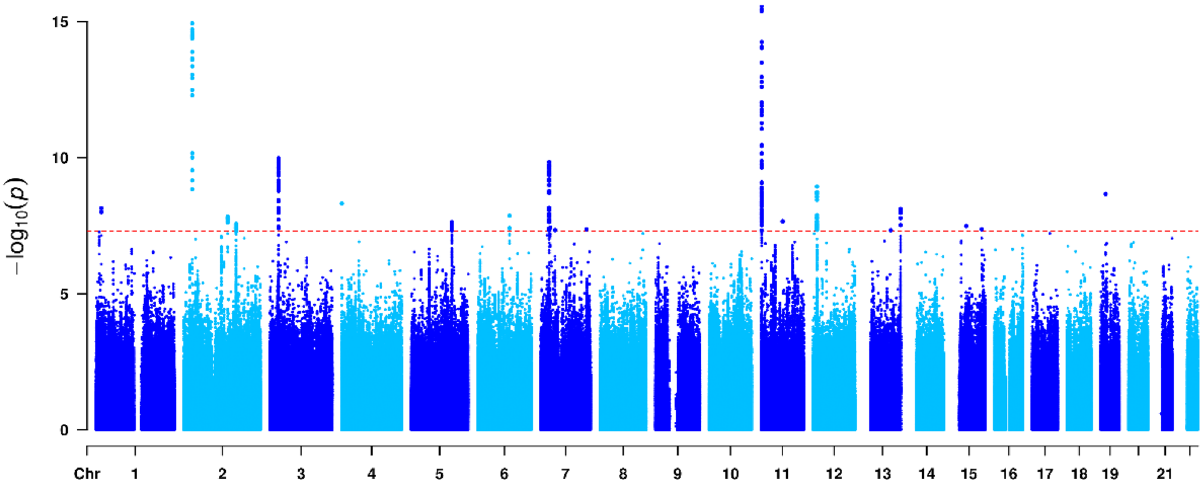
Figure 3. Manhattan plot visualizing genome-wide results from the vQTL analysis of SBP. Dots denote the SNPs in the genome-wide vQTL analysis, whose P values on a negative log 10 scale are plotted against their physical positions. The dashed line represents the genome-wide significance level (P = 5 × 10 −8